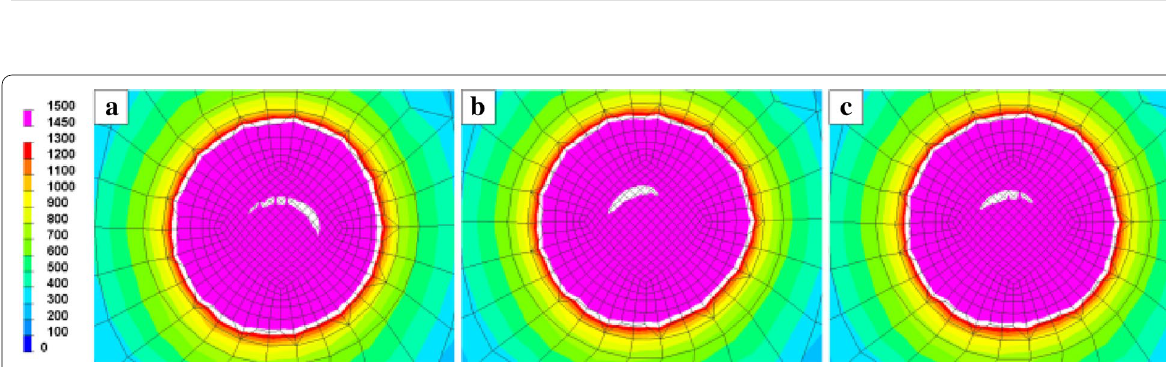
Figure 18 Temperature field of combined surface under different welding methods: a 4-sections; b 5-sections; c